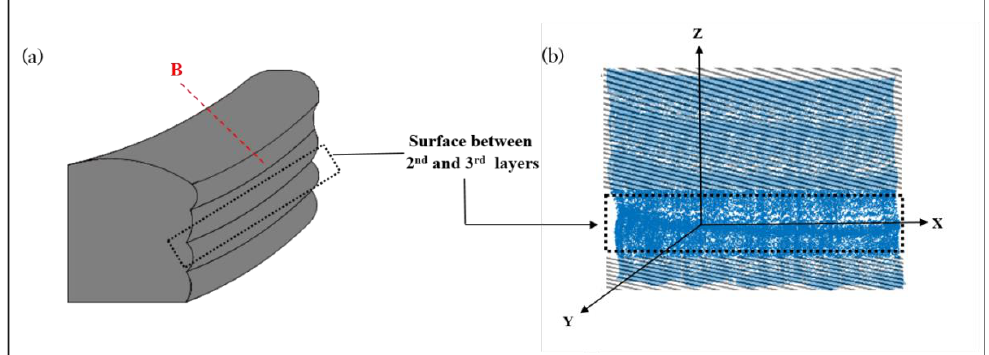
Figure 3. ( a ) Surface of WAAM product between second and third layers. ( b ) Reconstruction of WAAM product between second and third layers by